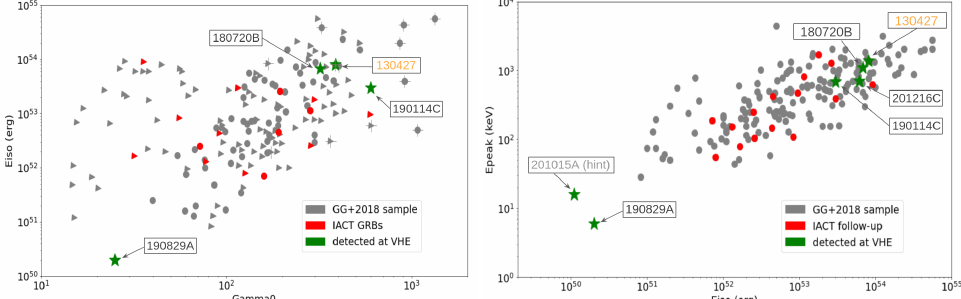
Figure 12. Left panel: Correlation between the bulk Lorentz factor at the beginning of the afterglow phase ( Γ 0 ) and the isotropic equivalent energy E iso for the sample of GRB reported in [91]. Right panel: the empirical correlation (Amati relation) between the isotropic equivalent energy E iso and the peak energy of the GRB spectrum for the same sample in [91] and for the events detected in the VHE band. In both panels, GRBs followed-up by IACTs are denoted by green and red symbols, indicating those with and without detection, respectively. Reprinted with permission from Ref.